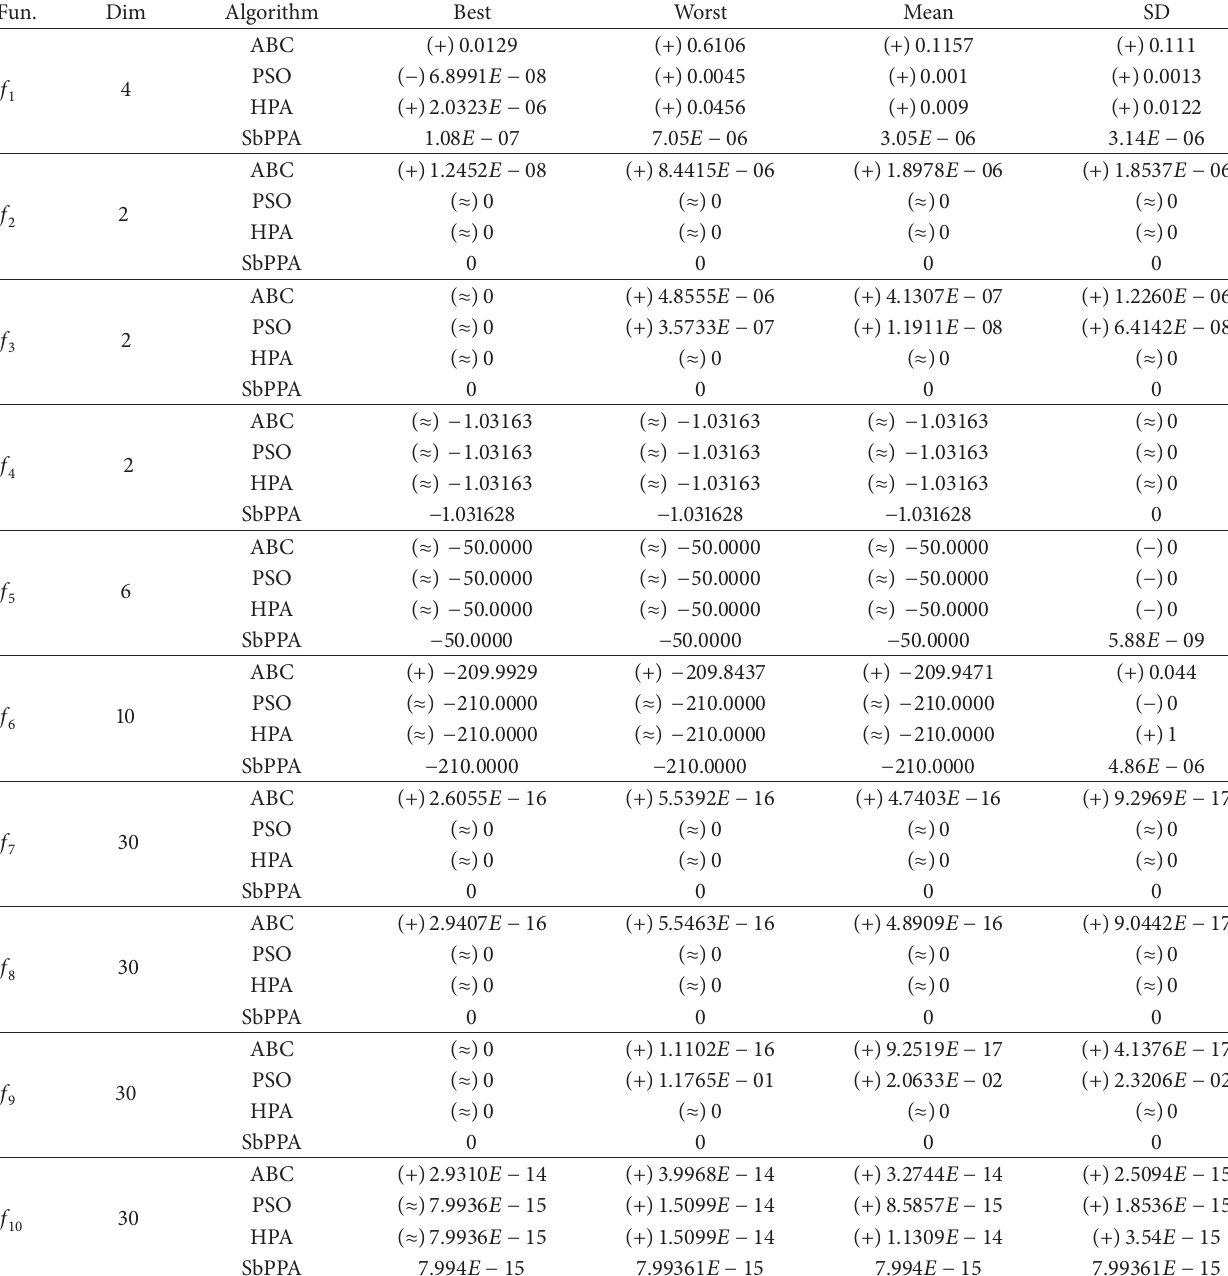
Table 4: Results obtained by SbPPA, HPA, PSO, and ABC. All problems in this table are unconstrained.